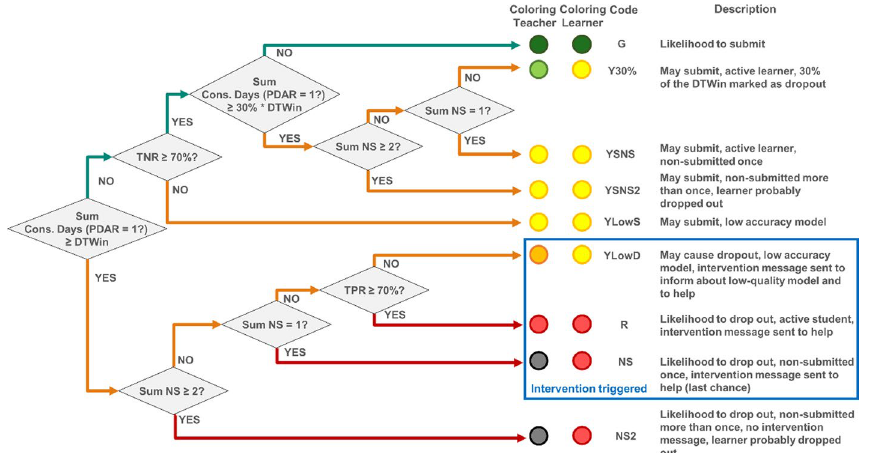
Fig. 2 Decision tree for the dropout risk‑level